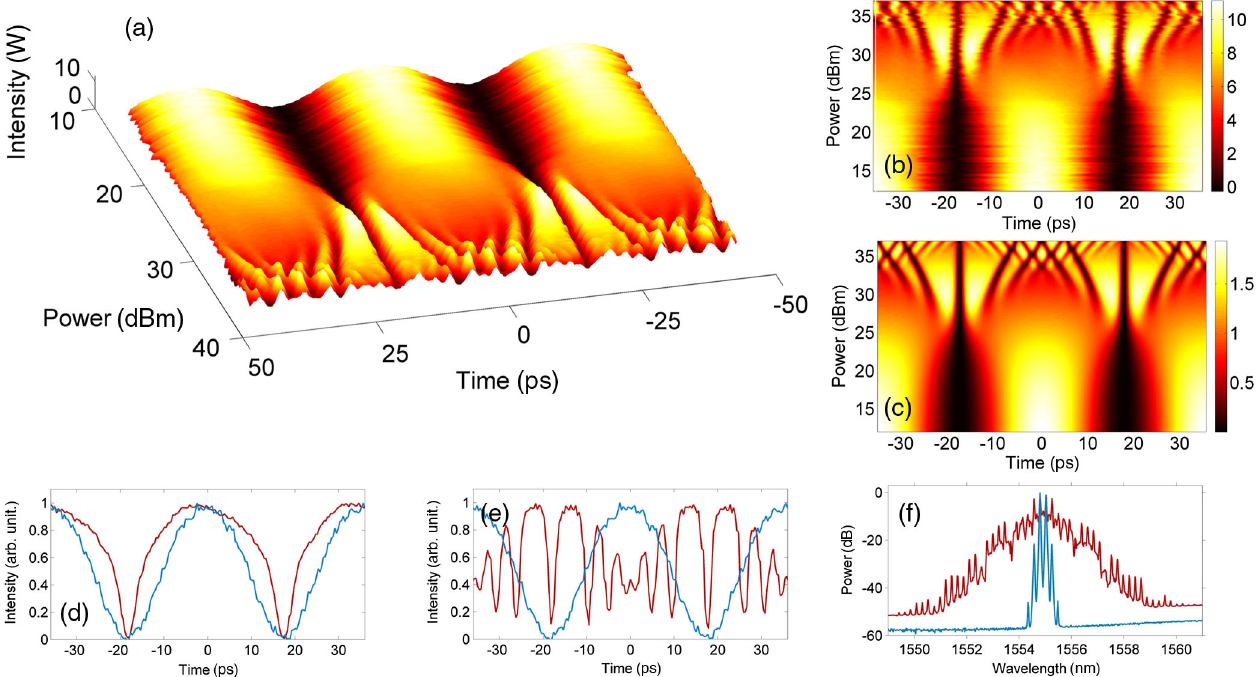
FIG. 4. Measured UB dynamics for symmetric dual-pumped FWM (cosine type of input, η ¼ α ¼ 0 ). (a) 3D surface of output power vs time and input power. (b),(c) Color-level plot from the output power profiles at different input powers from measured data (b), compared with numerical simulations of the dimensional NLS equation [(c), color level plot of j u j 2 ]. (d),(e) Temporal OSO traces at power levels: (d) P ¼ 25 . 6 dBm, close to breaking; (e) P ¼ 34 . 6 dBm, beginning of UB collision (the input is reported as a solid blue line). (f) Output spectra in the low-power ( P ¼ 13 dBm, preshock) and high-power ( P ¼ 34 . 6 dBm, postshock)